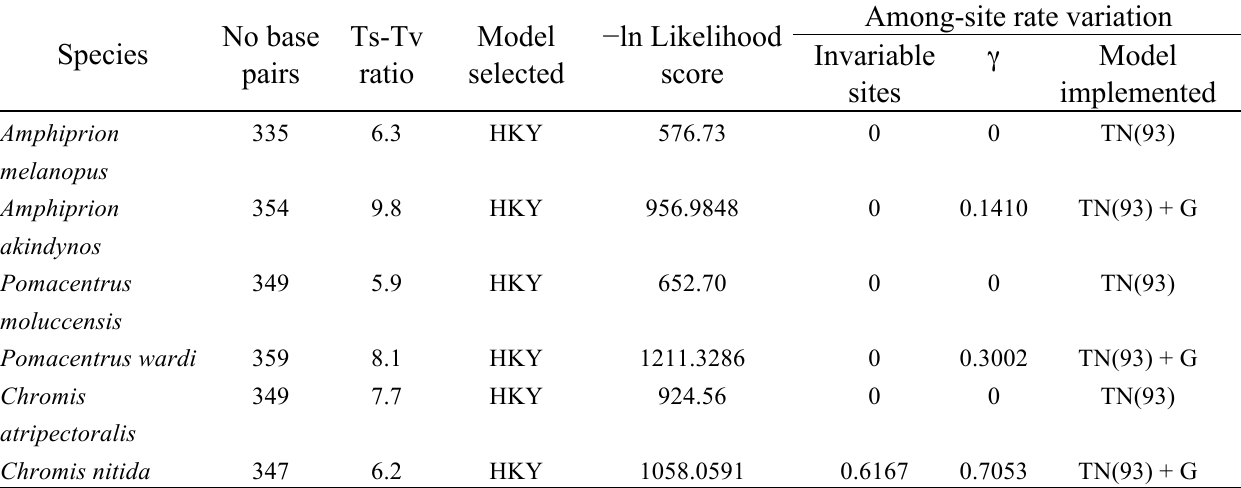
ESI Table 1. Number of base pairs, transition-transversion ratios (ts-tv) substitution models, gamma distribution shape parameter ( γ ), invariable sites and their likelihoods (determined by Modeltest) for the six species included in this